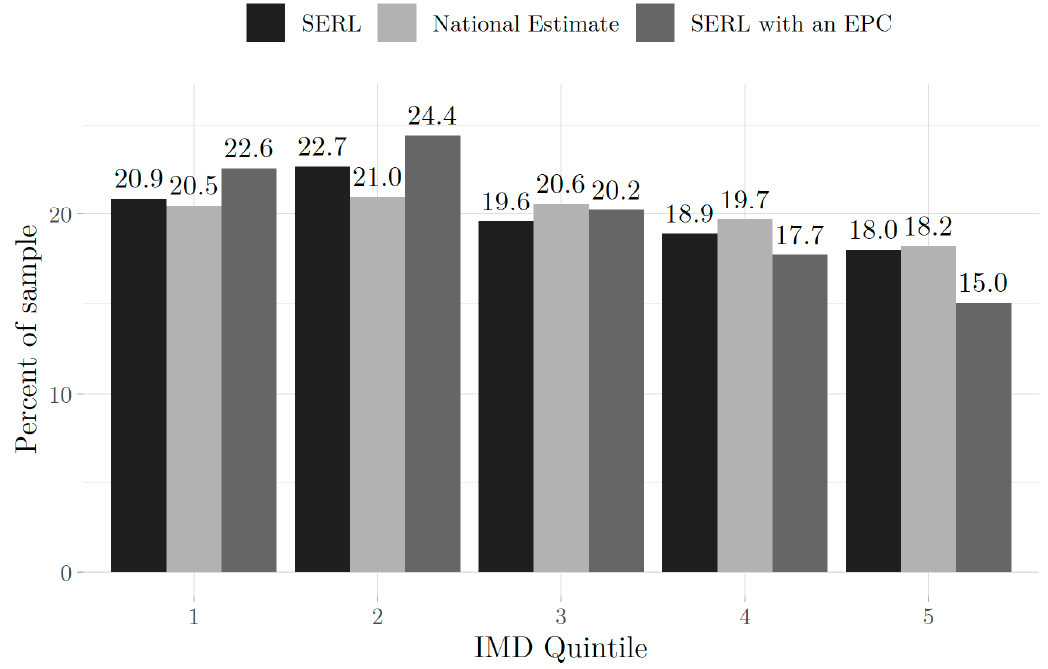
Figure 22. Representation of IMD quintiles in each sample: the full SERL sample (GB), a national estimate from Address Base (GB), and the SERL sample with an EPC (England and Wales).